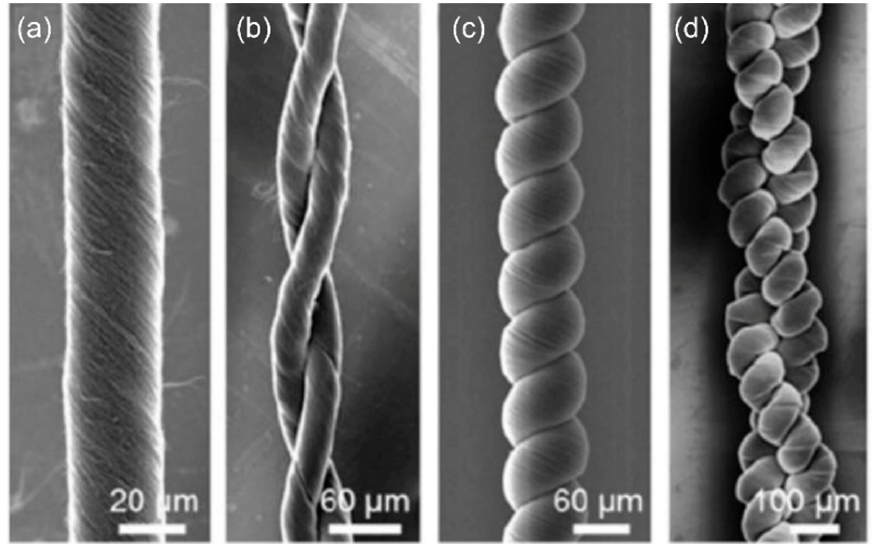
Figure 6. SEM images showing CNT yarns with different configurations, including: ( a ) single CNT yarn, ( b ) two-ply CNT yarn, ( c ) coiled CNT yarn, and ( d ) two-ply coiled CNT yarn. Reprinted with permission from Ref. [78]. 2020, Wiley-WCH.